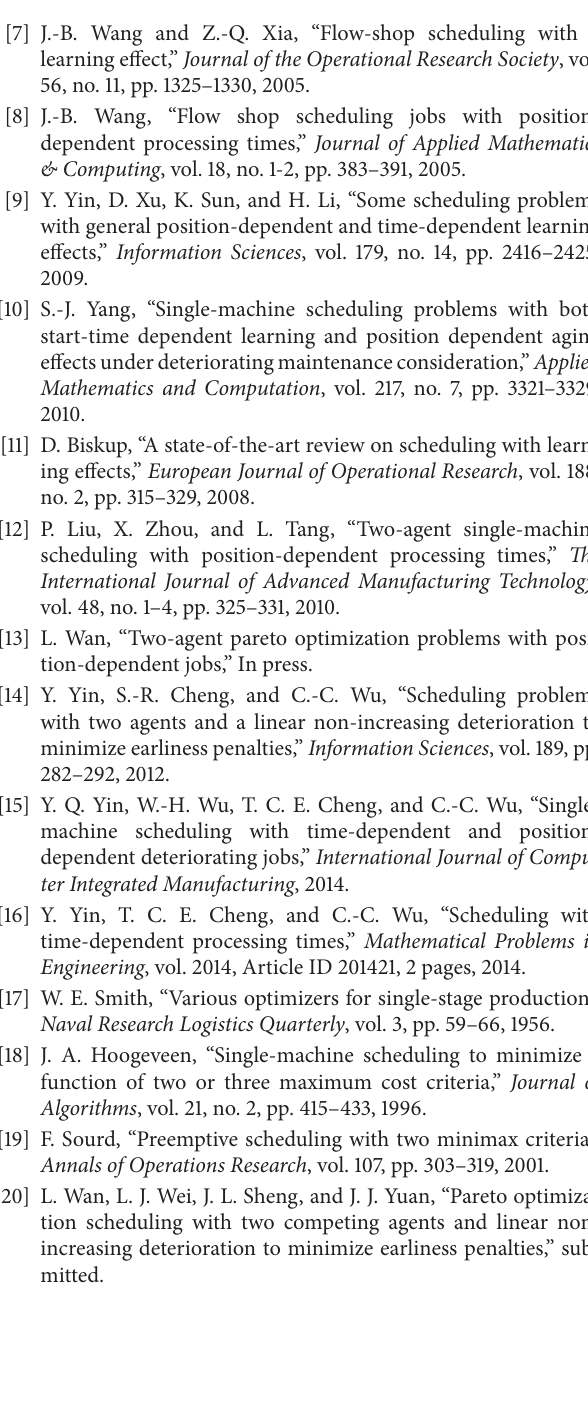
Algorithm C . For problem 1|𝑝 𝐴 ℎ𝑟 = 𝑝 𝐴 ℎ +𝑏𝑟, 𝑝 𝐵 𝑘 V = 𝑝 𝐵 𝑘 +𝑏 V |𝑓 𝐴 max ∘ 𝑓 𝐵 max